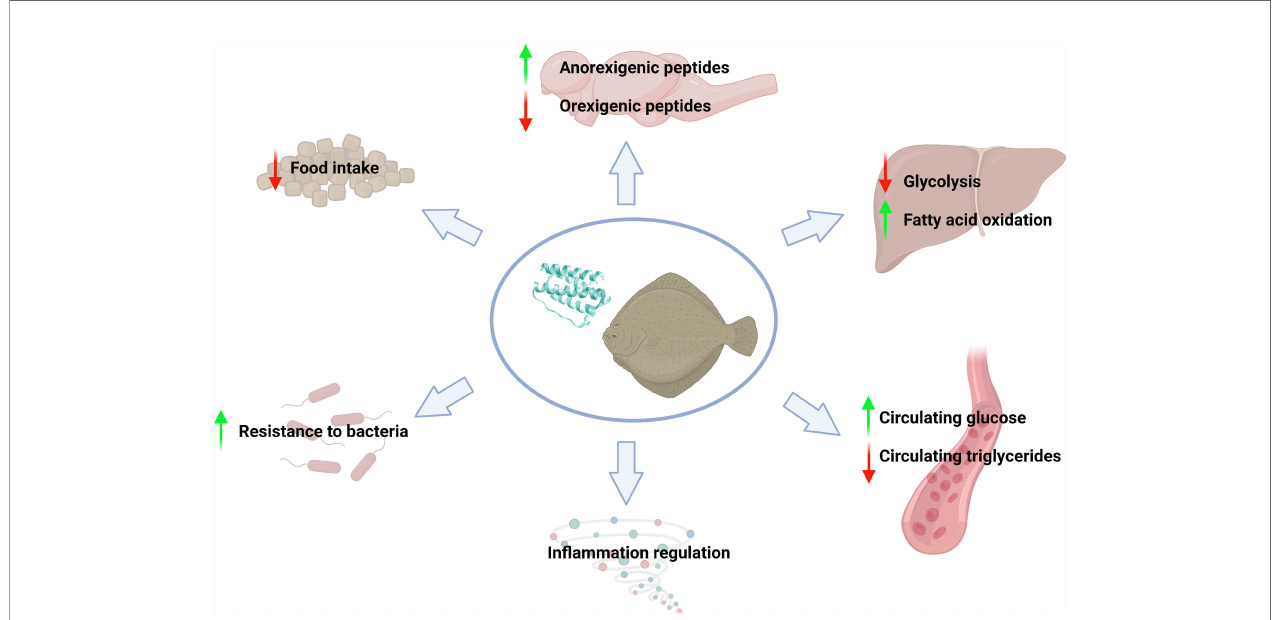
FIGURE 8 | Summary of the main effects mediated by recombinant human leptin administration in juvenile turbot. Figure created with